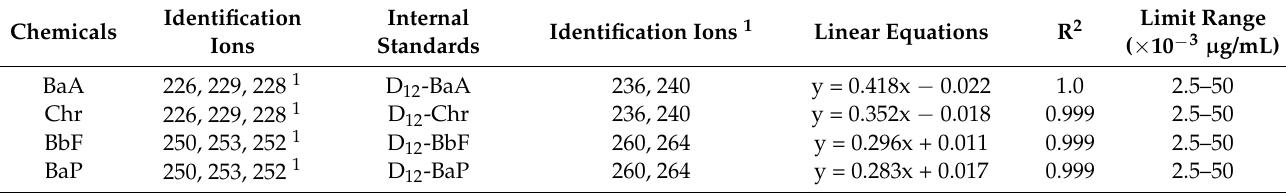
Figure 1. Mass chromatograph of the PAH4 and the D 12 -PAH internal standard. Table 1. Chemical monitoring ions and linear equations.